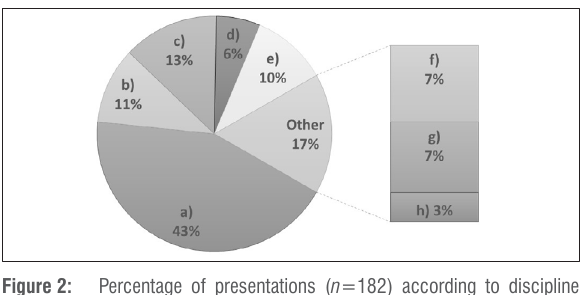
Figure 2: Percentage of presentations ( n =182) according to discipline or theme: a) zoology; b) botany; c) ecology; d) oceanography;